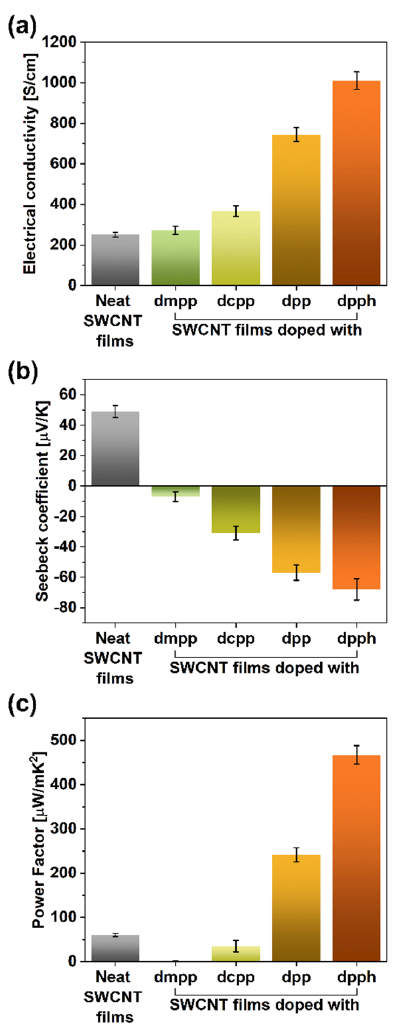
Figure 4. ( a ) Electrical conductivity values, ( b ) Seebeck coefficients, and ( c ) power factors of the SWCNT films before and after doping with organophosphorus compounds.